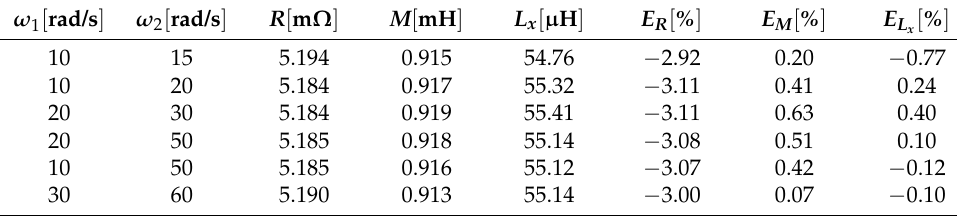
Table 2. Results of simulations with two sinusoidal voltage test